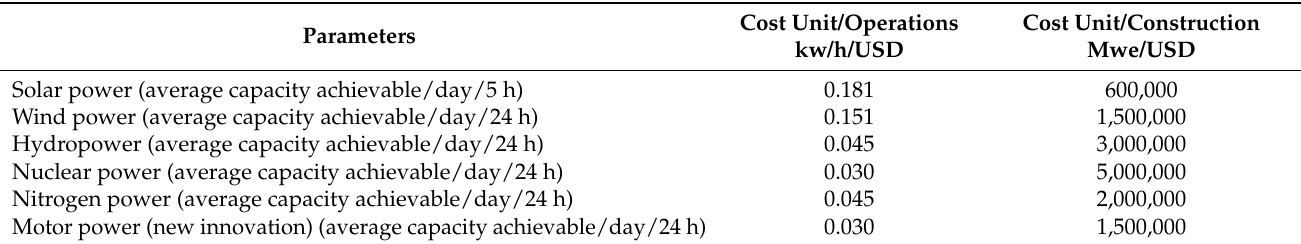
Table 7. Cost comparison for Implementation and construction of Technology